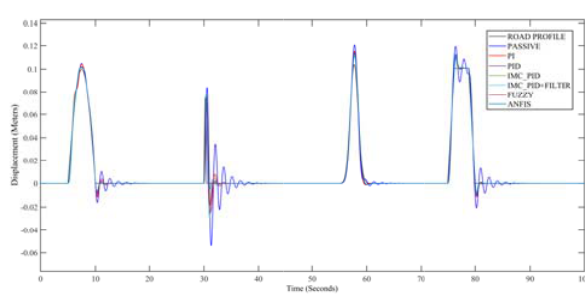
Fig. 20. is the response of various controllers against sum- mation of road profiles